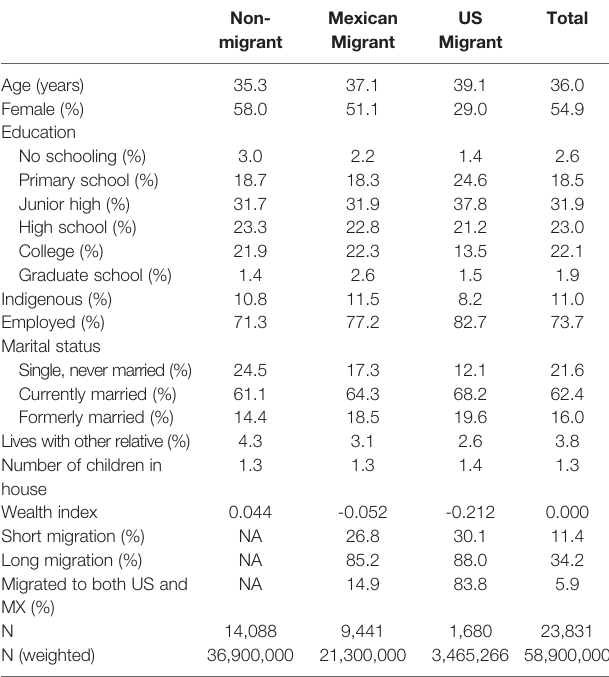
TABLE 1 | Descriptive statistics by migration status and destination